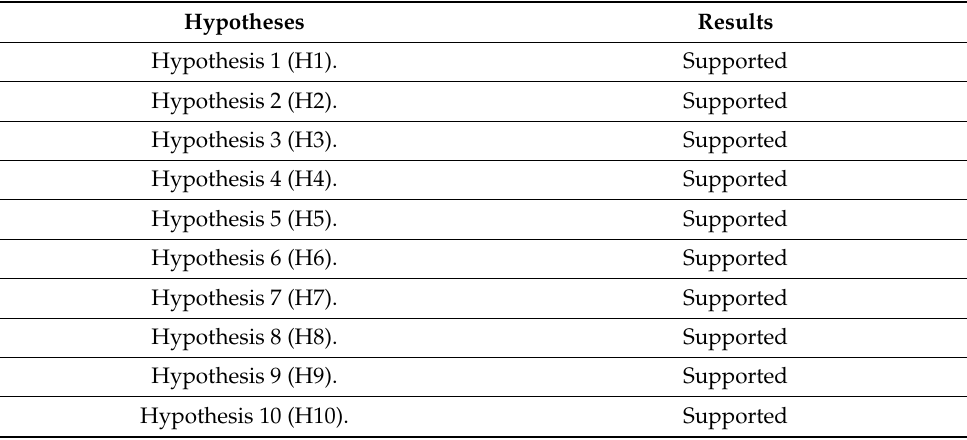
Table 7. Results of hypothesis